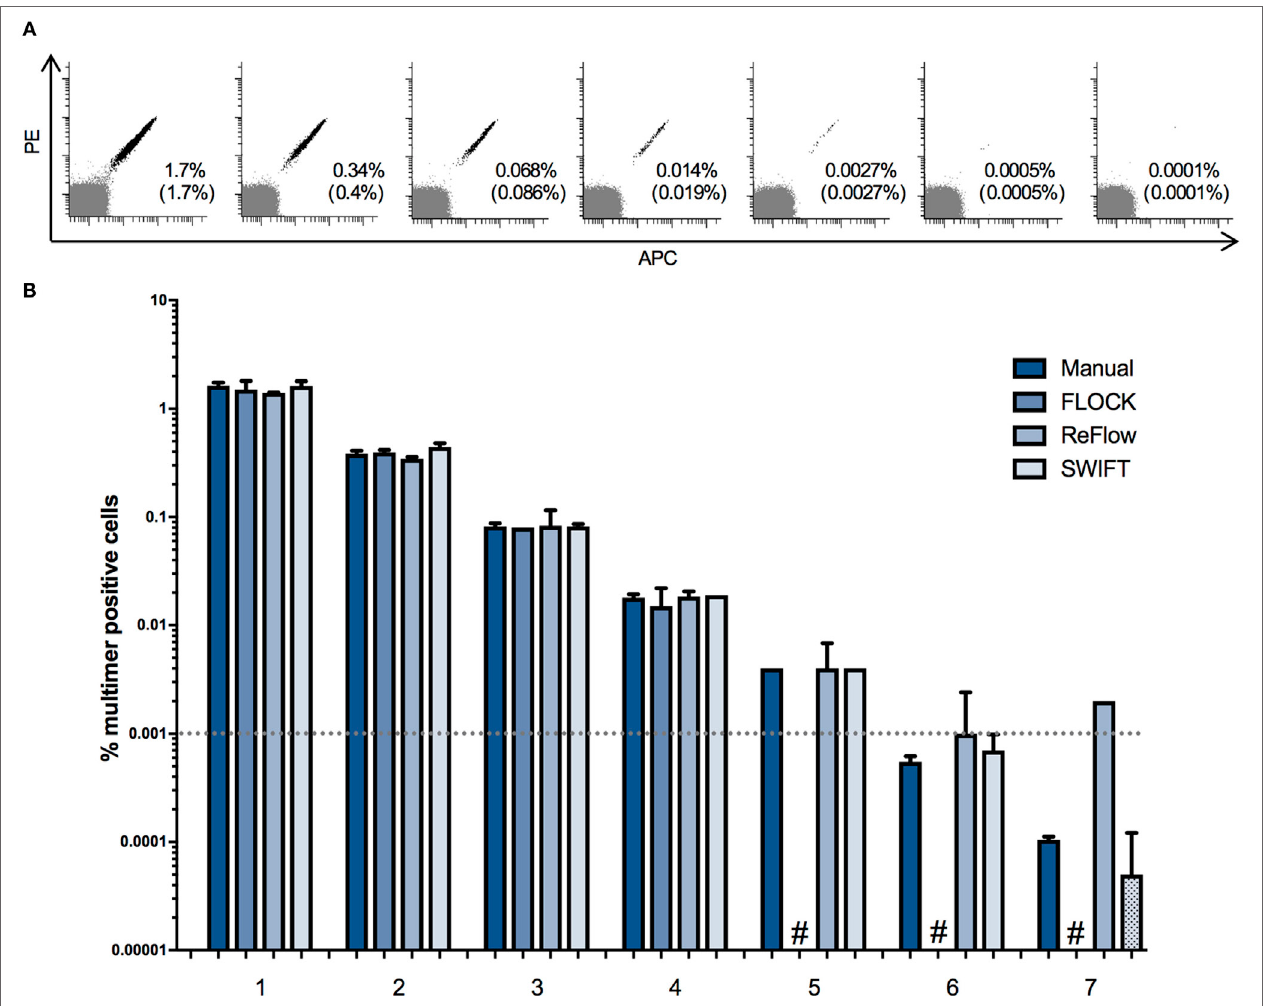
FigUre 2 | Limit of detection for different automated approaches. A donor carrying ~1.7% CD8 + T cells binding to HLA-B*0702 cytomegalovirus (TRP) was spiked into an HLA-B0702 negative donor in fivefold dilutions in order to assess the limit of detection of the four analysis approaches. The experiment was run in duplicates. (a) Dot plots of the spiked samples showing the theoretical frequency of multimer + cells of the total lymphocyte population and the actual detected frequency (in brackets) by manual gating. Multimer + cells are double positive for PE and APC. PE: phycoerythrin; APC: allophycocyanin. (B) The mean percentage of multimer positive cells out of single, live lymphocytes. Numbers represent the seven different samples. Dotted bars: the software detected zero specific cells in one of the two duplicates. #: the software was unable to detect the specific populations in both duplicates. Dashed line: a typical detection threshold for positive response in a major histocompatibility complex multimer